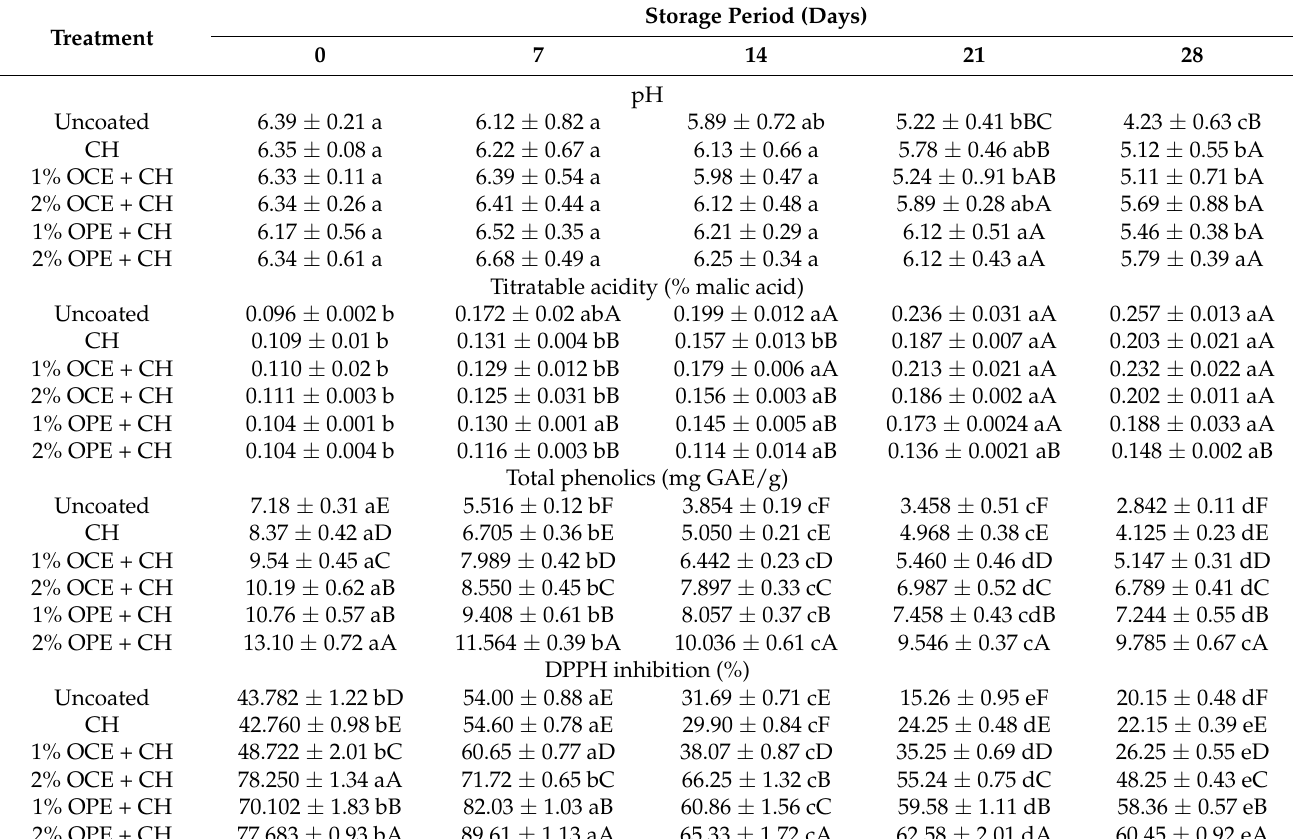
Table 2. Changes in pH, acidity, total phenolics, and antioxidant activity of fresh Barhi dates coated with chitosan and/or olive cake or orange peel extracts during cold storage (4 ◦